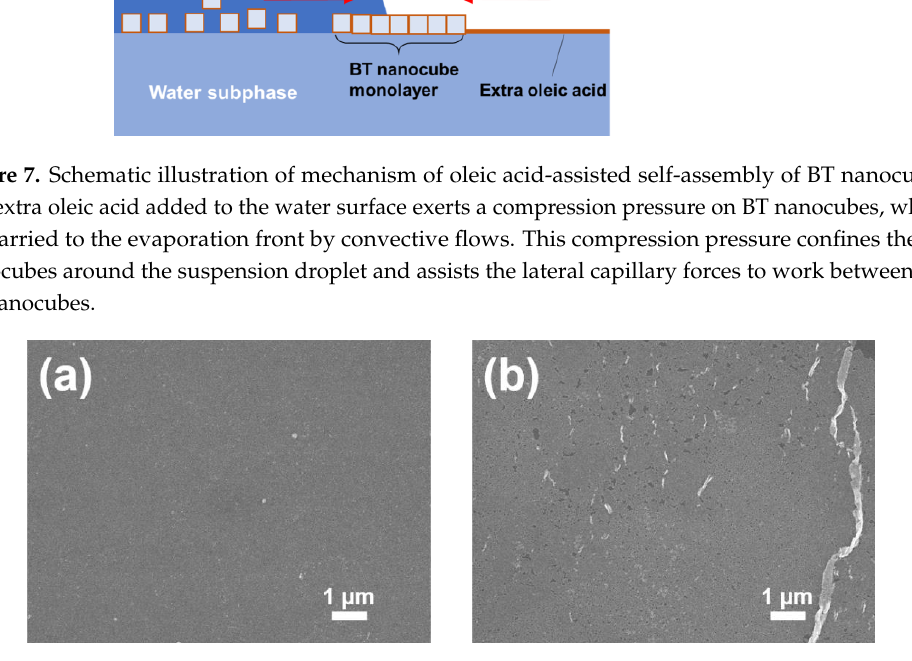
Figure 8. SEM images of BT nanocube monolayers fabricated using ( a ) our method and ( b ) Langmuir– Blodgett